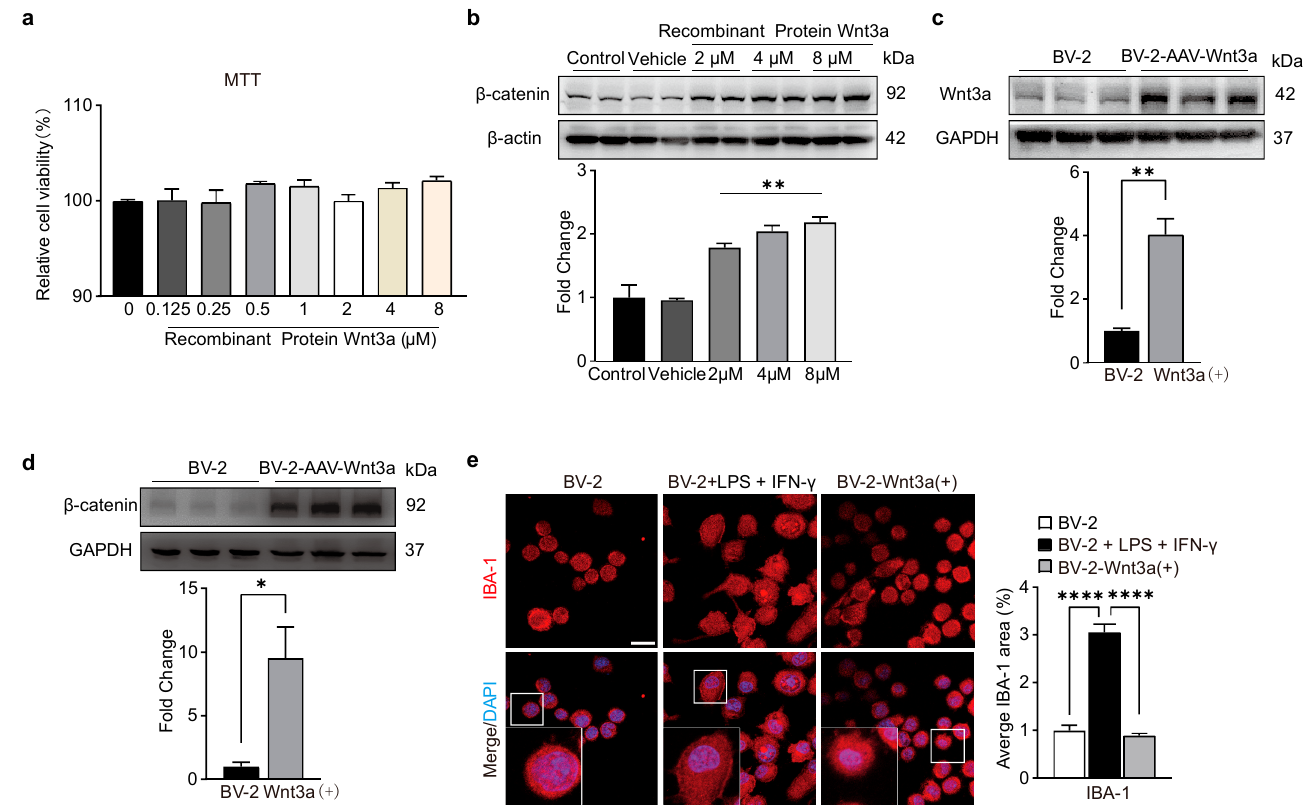
Figure 2. Overexpression of Wnt3a did not alter the morphology of BV-2 cells. ( a ) Treatment of BV-2 cells with RM Wnt3a at di ff erent concentrations. The cell viability was evaluated by CCK-8 assay. One-way ANOVA, F (7, 16) = 1.705, p > 0.05, n = 3. ( b ) Western blot analysis of expression of β - catenin in BV-2 cells after RM Wnt3a. Top, representative bands. Bo tt om, data summary. One-way